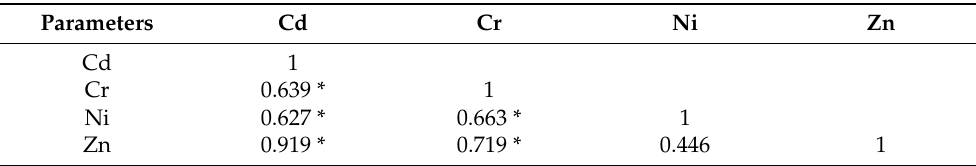
Table 6. Pearson’s Correlation matrix among the Heavy Metals in the Dhaleshwari River (significance of correlation was measured both at 0.05 levels).